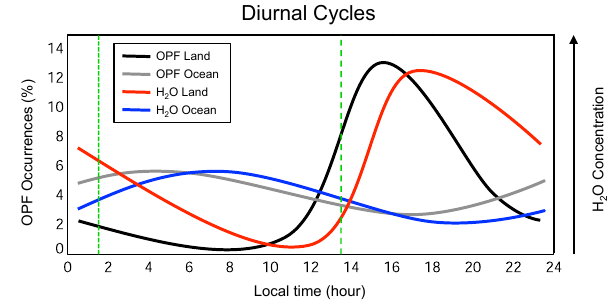
Figure 3. Diurnal variation of population of 20 ! N–20 ! S OPFs identified with five reference heights over land (solid) and ocean (shaded). Figure 1. Schematic representation adapted from Liu and Zipser (2005) of the diurnal overshooting precipitation features (OPF) cycle in the UT above continental areas (black solid line) and above oceanic areas (grey solid line) with the expected diurnal H 2 O mixing ratio cycle above continental areas (red solid line) and above oceanic areas (blue solid line). Green dotted lines show the MLS local sampling